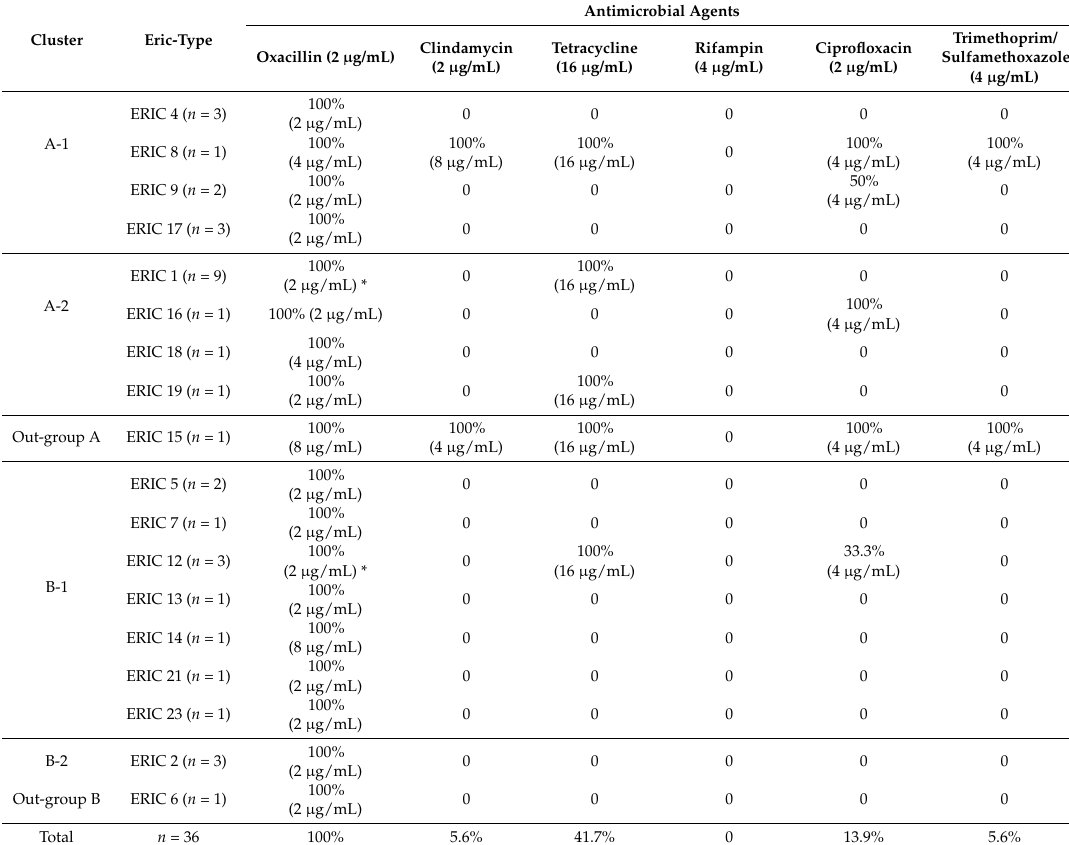
Table 2. Proportion of L. innocua isolates from a river basin in Taiwan showing resistance (%) to six antimicrobial agents by ERIC